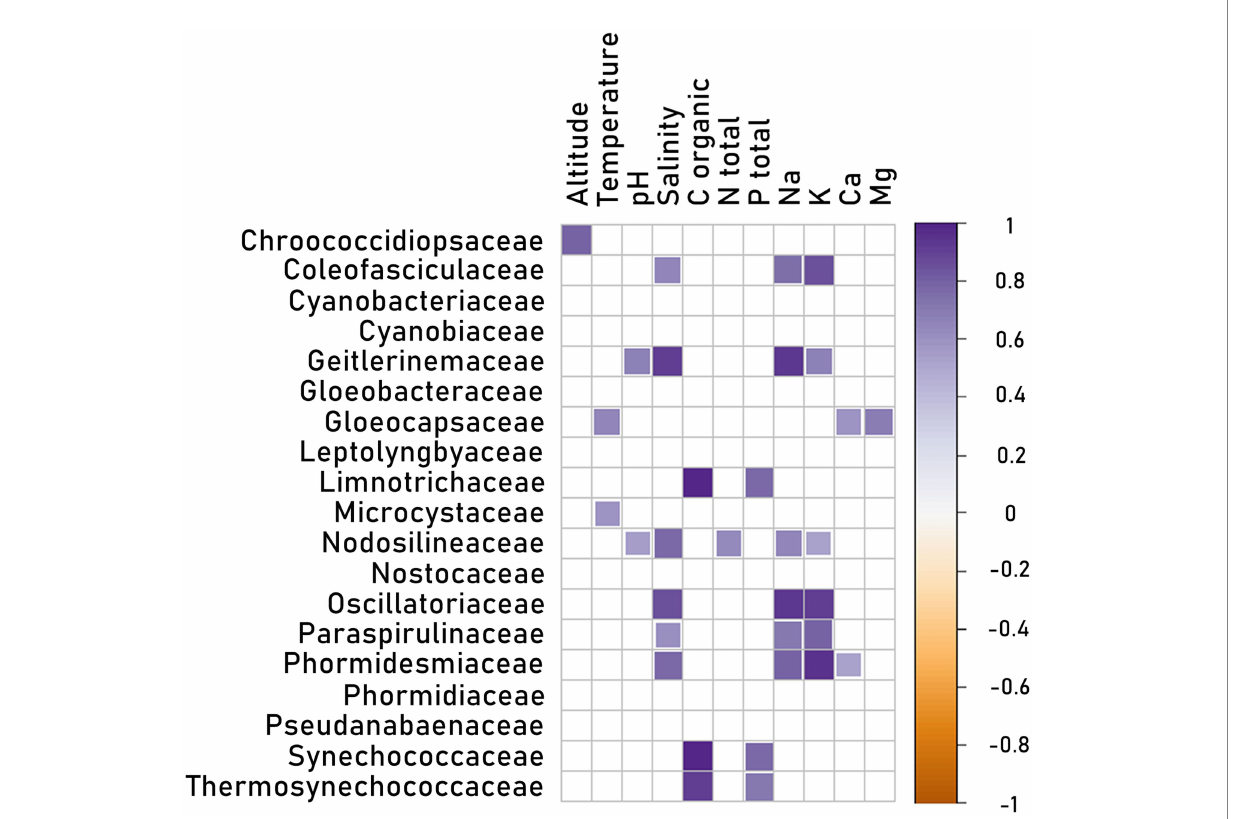
FIGURE 10 Matrix of Spearman’s rank correlations for environmental parameters (altitude, temperature, pH, salinity, total organic C, total N, total P, PO 43 − , NH 3+ , Na + , K + , Ca +2 , Mg +2 ) and Cyanobacteria family reads in 48 samples merged into 15 representative groups (group K_Nl was excluded because of lack of environmental